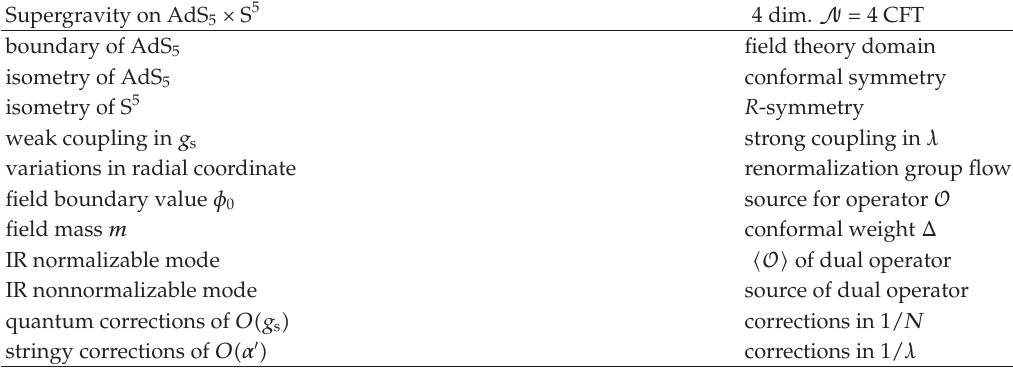
Table 1: A few examples for entries of the AdS/CFT dictionary. Precise operator-field pairings can be found, for example, in (cid:8) 3, 4, 8, 9 (cid:9)